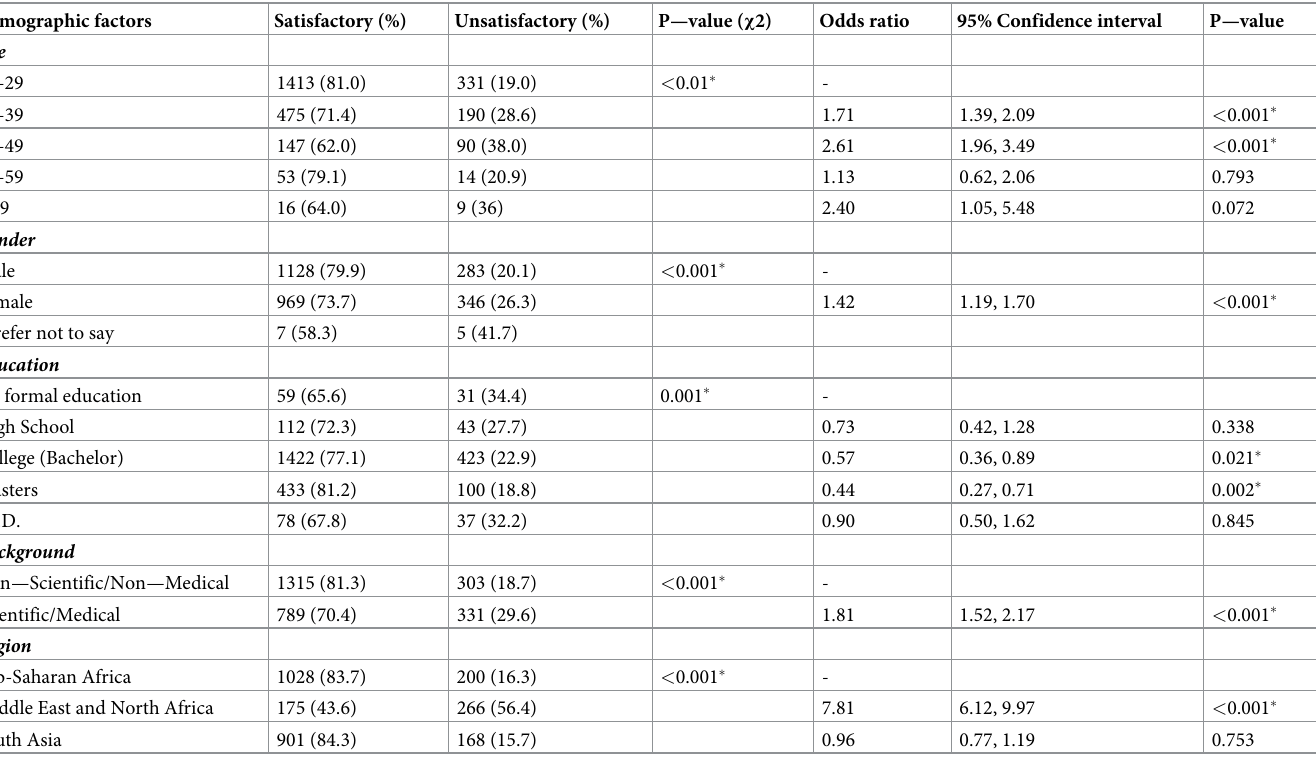
Table 6. Binary logistic regression analysis of demographic factors affecting respondents’ attitudes about the COVID-19 pandemic from the three regions. Demographic